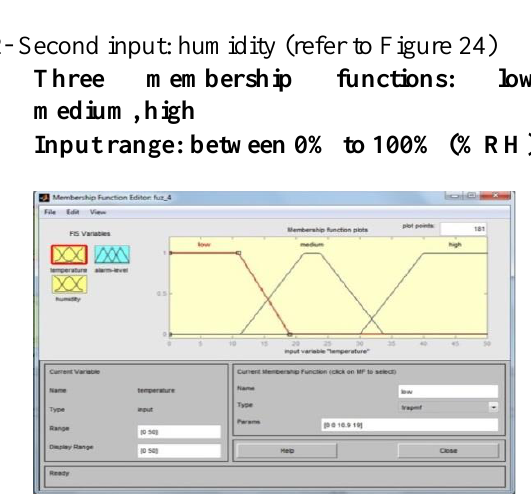
Figure 23. Membership functions for temperature (input) and its